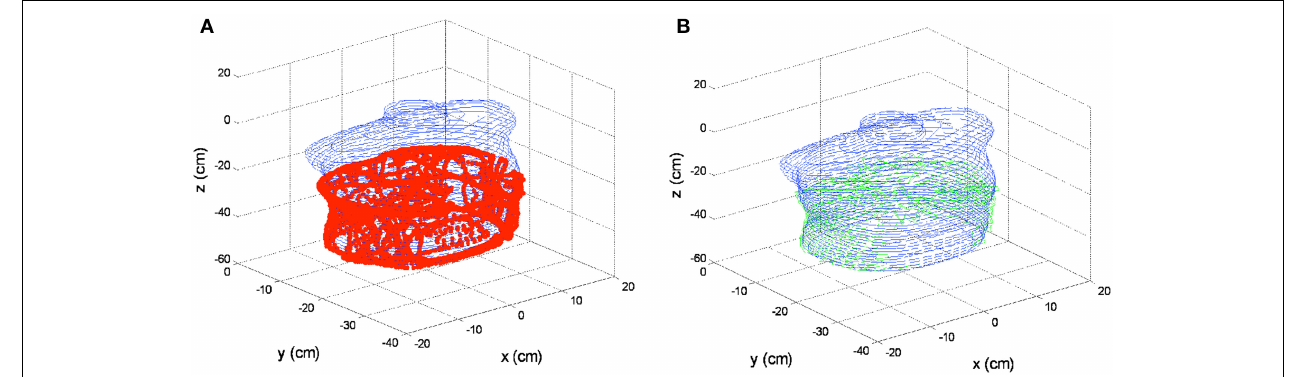
FIGURE 7 | 3D contour results on phantom. (A) Cavity surface positions by the pleural PDT navigation system (red dots) and surface contour determined by the CT images (blue lines). (B)